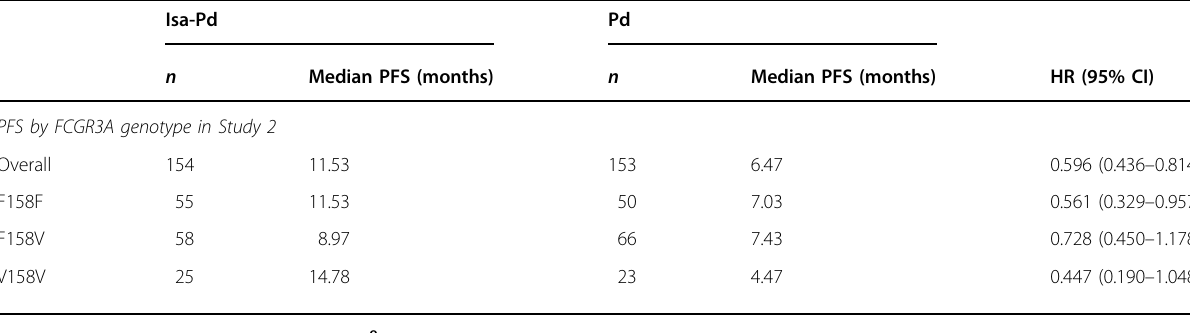
Table 1 Predictive value of baseline immune